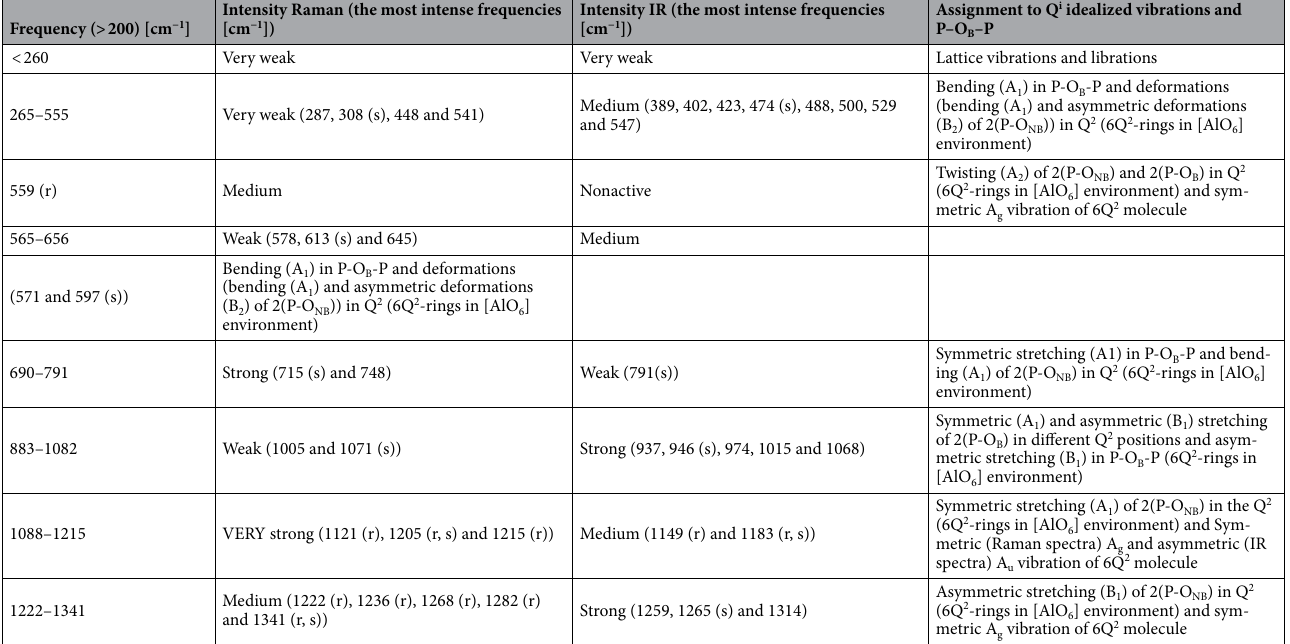
Table 4. The calculated Raman and IR active modes of aluminum cyclohexaphosphate -Al(PO3)3 (more details in the supplementary materials Table S1.4). r—frequency assigned to the 6Q 2 ring, s—the strongest in the range.